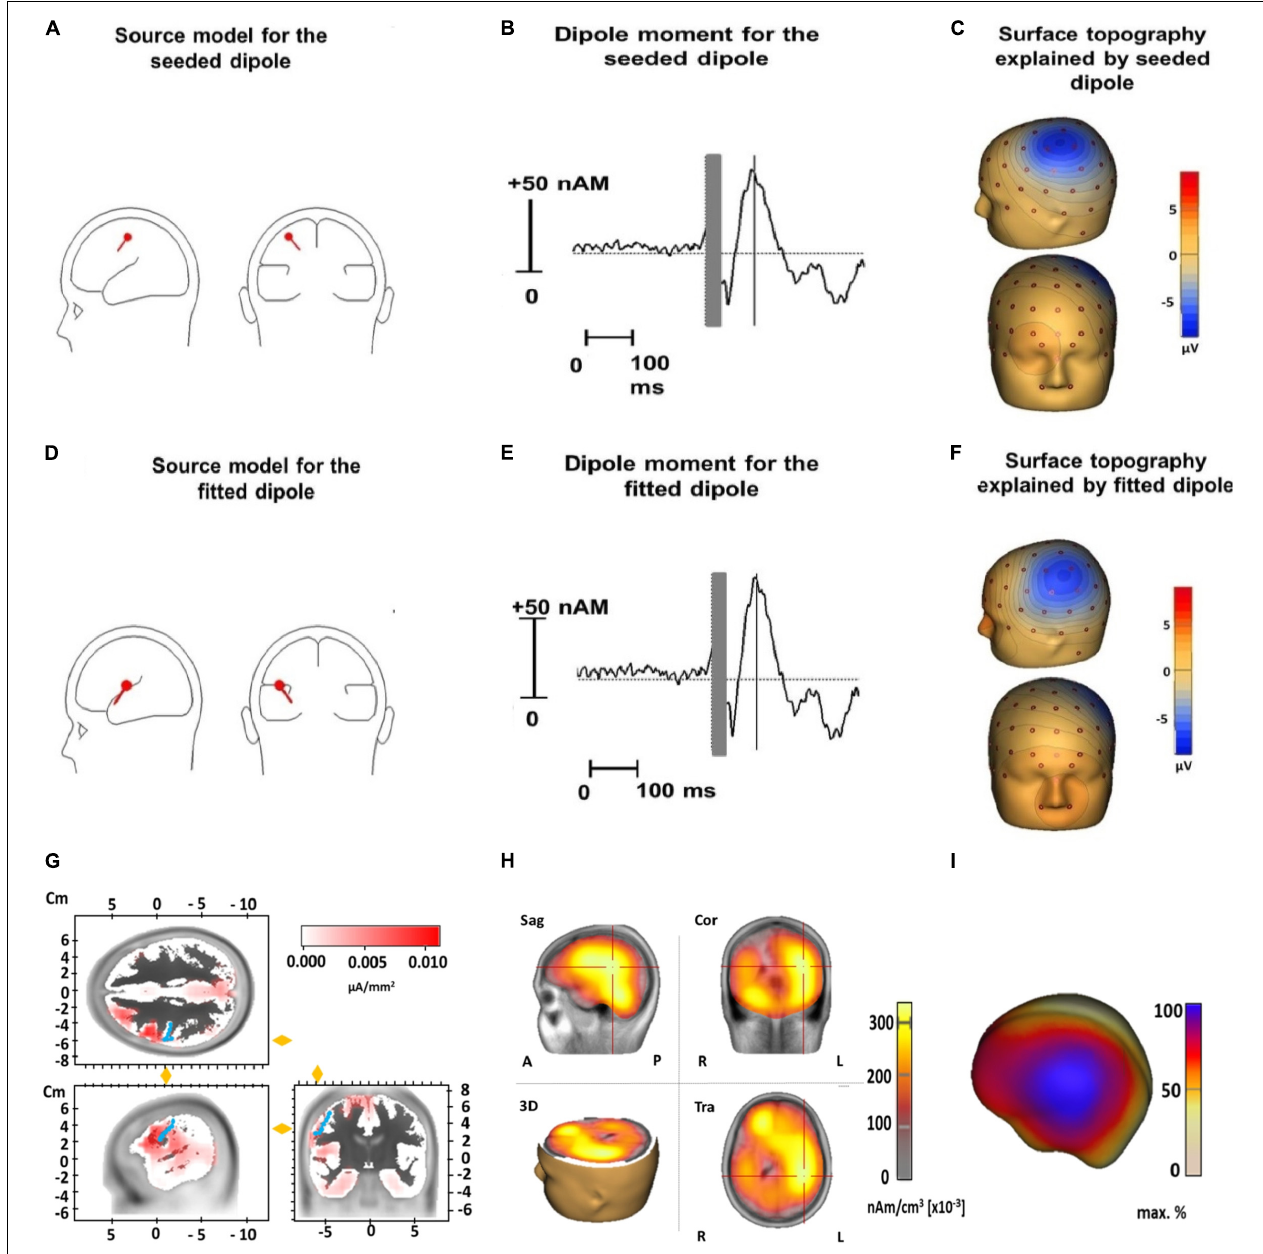
FIGURE 5 | Source analysis of TMS-evoked N100 for the dipole seeded to the standard motor cortex coordinates ( x = –33, y = –18, and z = 52) (upper row) and for the dipole fitted to our data (middle row) and LORETA results (lower row). Displayed are the dipole source localization and orientation for the seeded (A) and fitted dipole (D) and the dipole moment for the seeded (B) and fitted dipole (E) as well as the surface topography of the seeded (C) and fitted dipole (F) . Panel (G) illustrates LORETA results when the source space is limited to cortical areas in an averaged standard brain for the N100 time window 80–120 ms (Brain Vision Analyzer 2.2). Activation is fitted by LORETA to cortical areas in the vicinity of the precentral gyrus (marked by blue dots). Note that an exact localization without individual structural magnetic resonance images is not possible in a reliable way. Panel (H) shows LORETA results when the solution space is not restricted to the cortical surface in the time window 80–120 ms. Similar to Panel (D) it pictures a deeper activation maximum in the brain due to widespread cortical surface activation (see Panel I and Figure 2 ) (Sag, Sagital slices; Cor, Coronal slices; Tra, Transaxial slices; R, Right; L, Left; A, Anterior; P, Posterior). In panel (I) a projection of LORETA source activity on the cortical surface (BESA Research 7.1) with widespread cortical activation in the central region is displayed. This widespread topography corresponds well to the surface topography of the N100 as can be seen in Figure 2 .